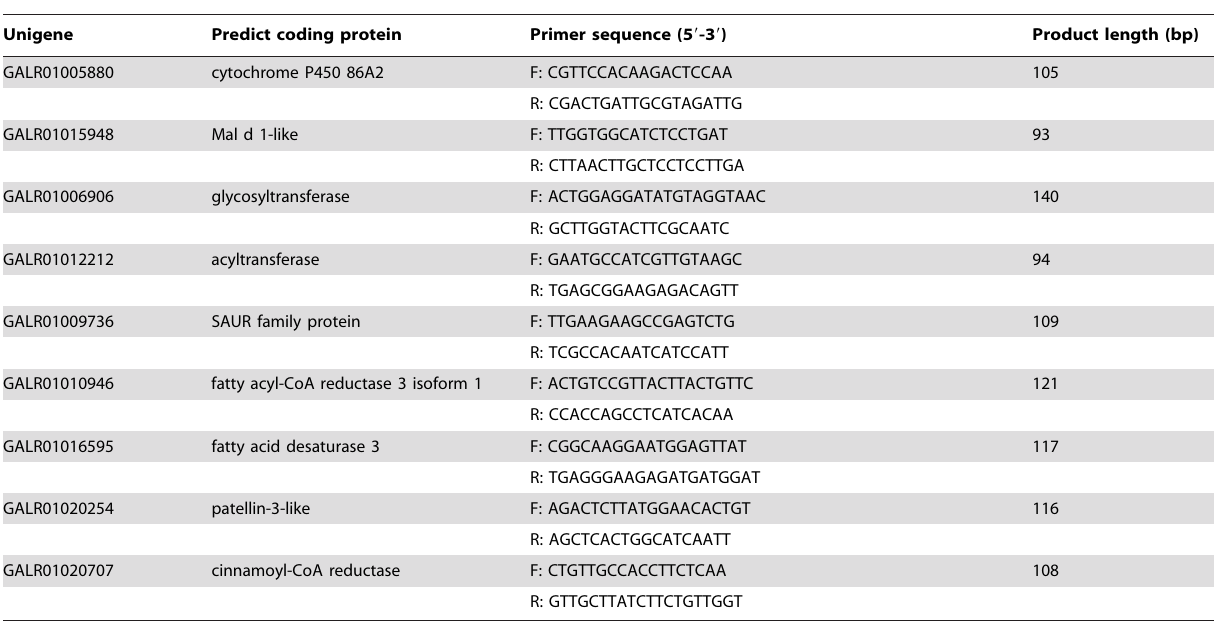
Table 1. Primers of selected genes used for qRT-PCR analysis.